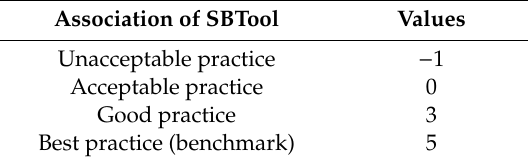
Table 1. Association of values—proposed by Sustainable Building Tool